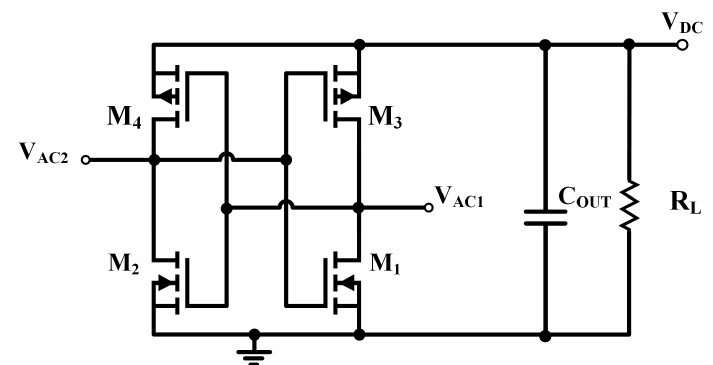
Figure 6. Cross-coupled rectifier